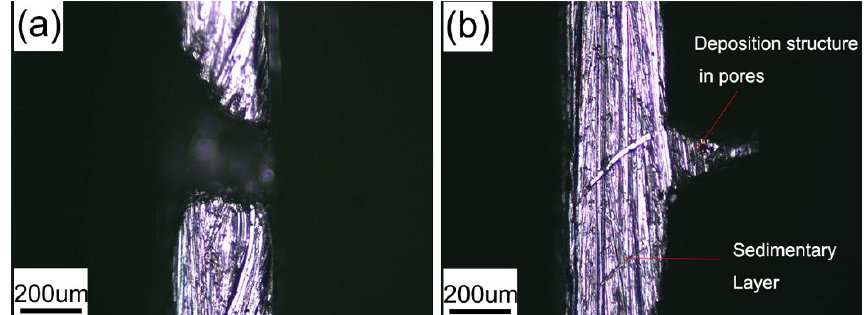
Figure 3. ( a ) The section morphology of the bell-mouthed macropores in the deposition in Figure 2c and ( b ) the protrusion structure of the deposition in Figure 2d. Table 1. Surface tension of the solution with different contents of sodium lauryl